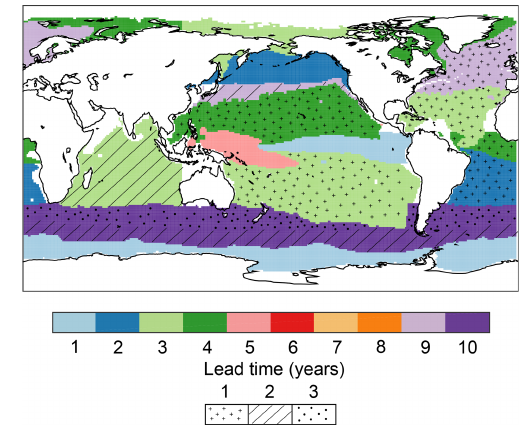
Figure 10. For each biome, the maximum forecast lead time (years) in which the initialized CESM-DPLE CO 2 flux forecast has both higher predictability than the uninitialized CESM-LE forecast and a higher correlation coefficient than the persistence forecast. Hatch- ing shows the maximum forecast lead time while accounting for statistical separation of correlation coefficients at the 95% level us- ing a z